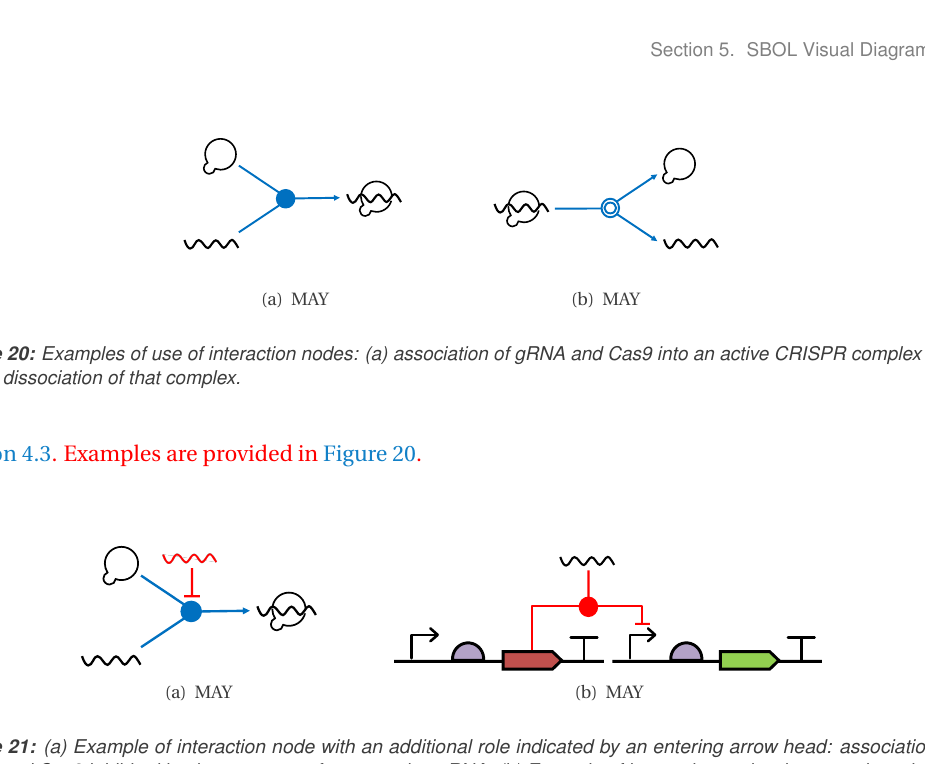
Figure 21: (a) Example of interaction node with an additional role indicated by an entering arrow head: association of gRNA and Cas9 inhibited by the presence of a competing gRNA. (b) Example of interaction node whose product plays a role in another interaction: dCas9 and gRNA associate to form a CRISPR complex, which then represses a promoter.